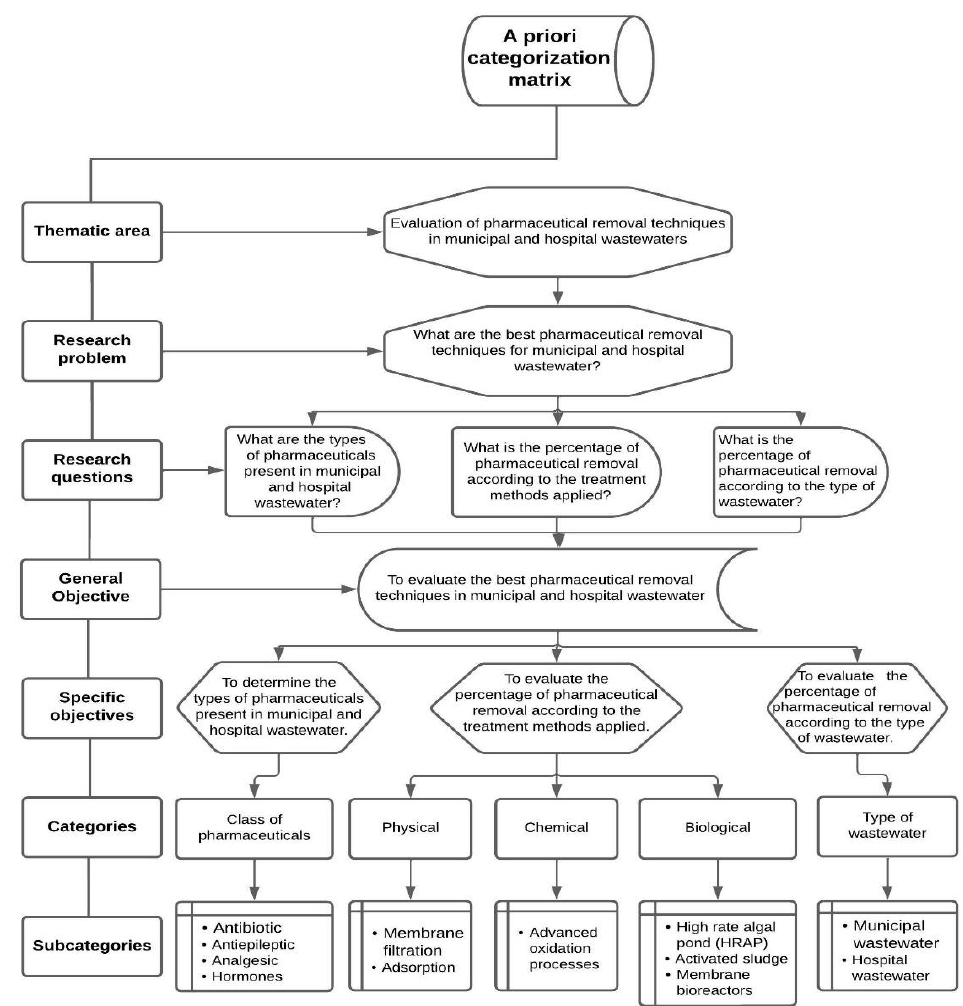
Figure 1. A priori categorization matrix.